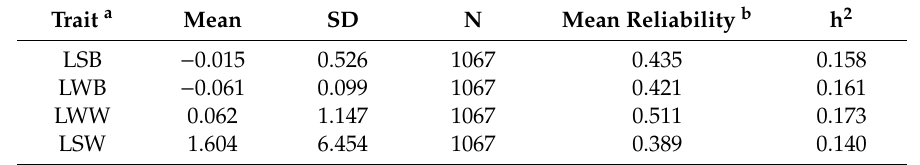
Table1. Phenotypes(de-regressedestimatedbreedingvalues(EBVS))offourporcinereproductiontraits. Trait a Mean SD N